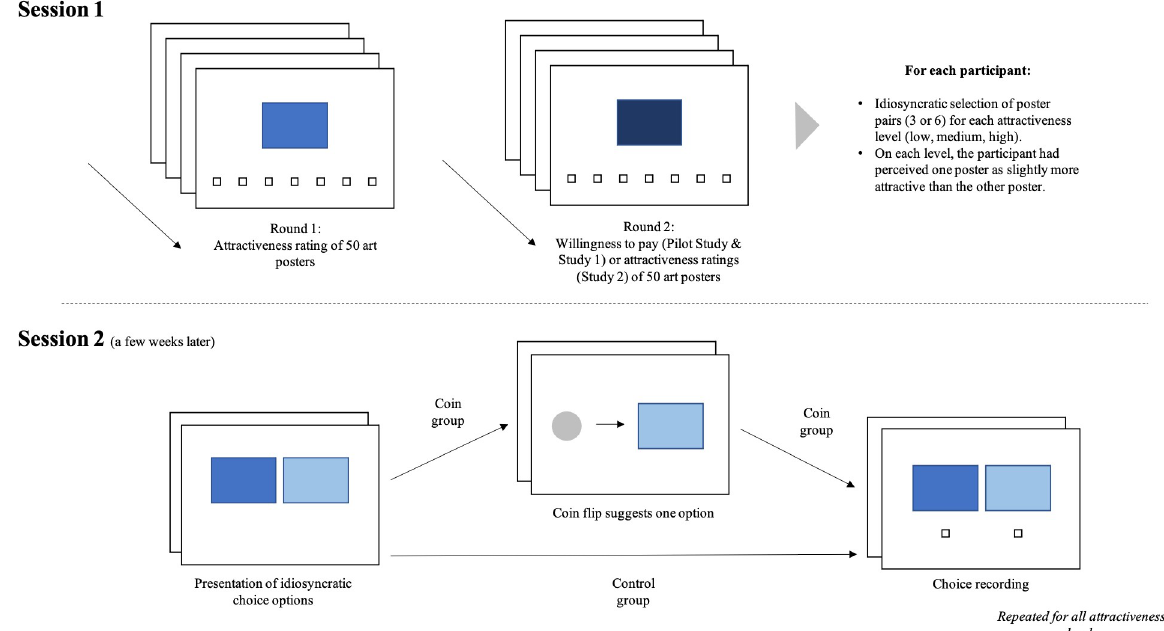
Fig 1. Illustration of procedures used throughout the presented